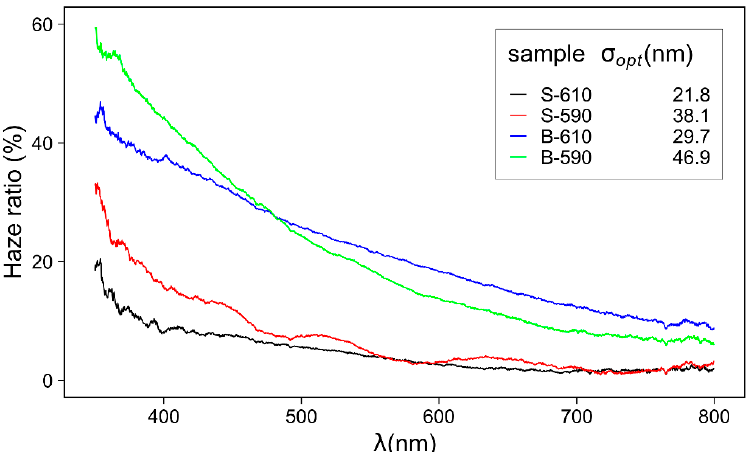
Figure 9. Spectral distribution of transmittance haze ratio for single- and double-layer SnO 2 thin films. Surface roughness values are obtained by Equation (6).